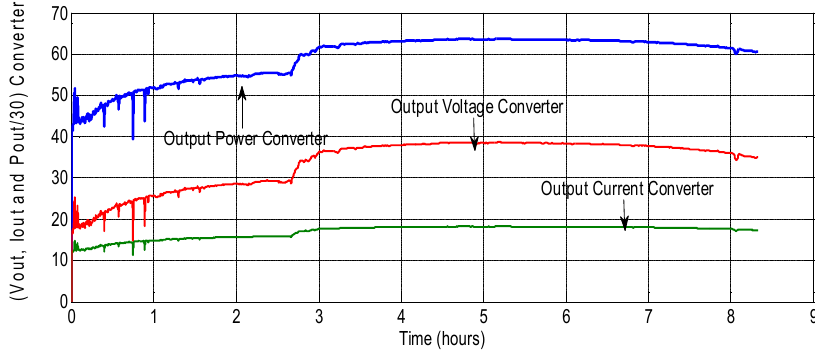
Figure 14. Outputs (V0, i L , and power) from the converter vs. time.